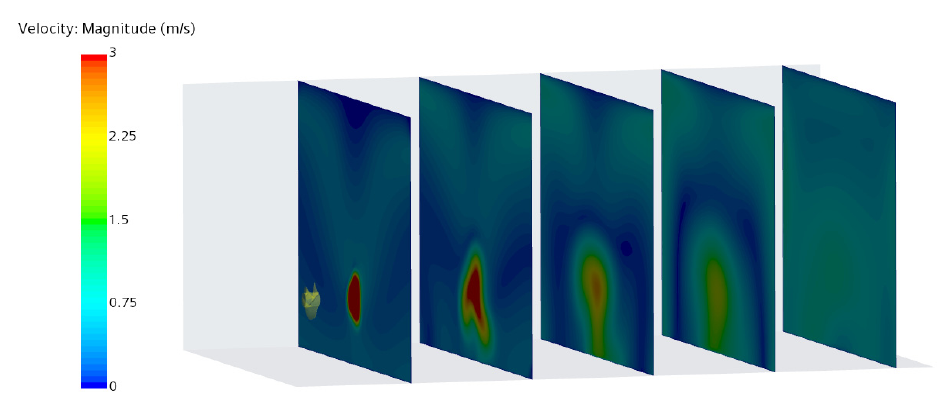
Figure 5. Velocity contour of multiple axial sections.